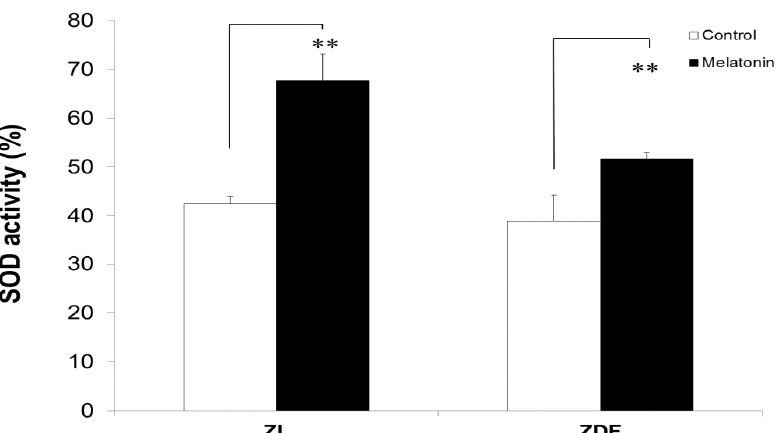
Figure 6. The effect of melatonin treatment on superoxide dismutase (SOD) activity in mitochondria isolated from BAT of control (untreated) and melatonin-treated ZDF and ZL rats. Values are expressed as mean ± SD. Superscript letters identify significant difference measured using two-way ANOVA followed by the Tukey post hoc test. ZL, Zücker lean rats; ZDF, Zücker diabetic fatty rats. ** p < 0.01, M-ZDF compared with C-ZDF rats and M-ZL compared with C-ZL